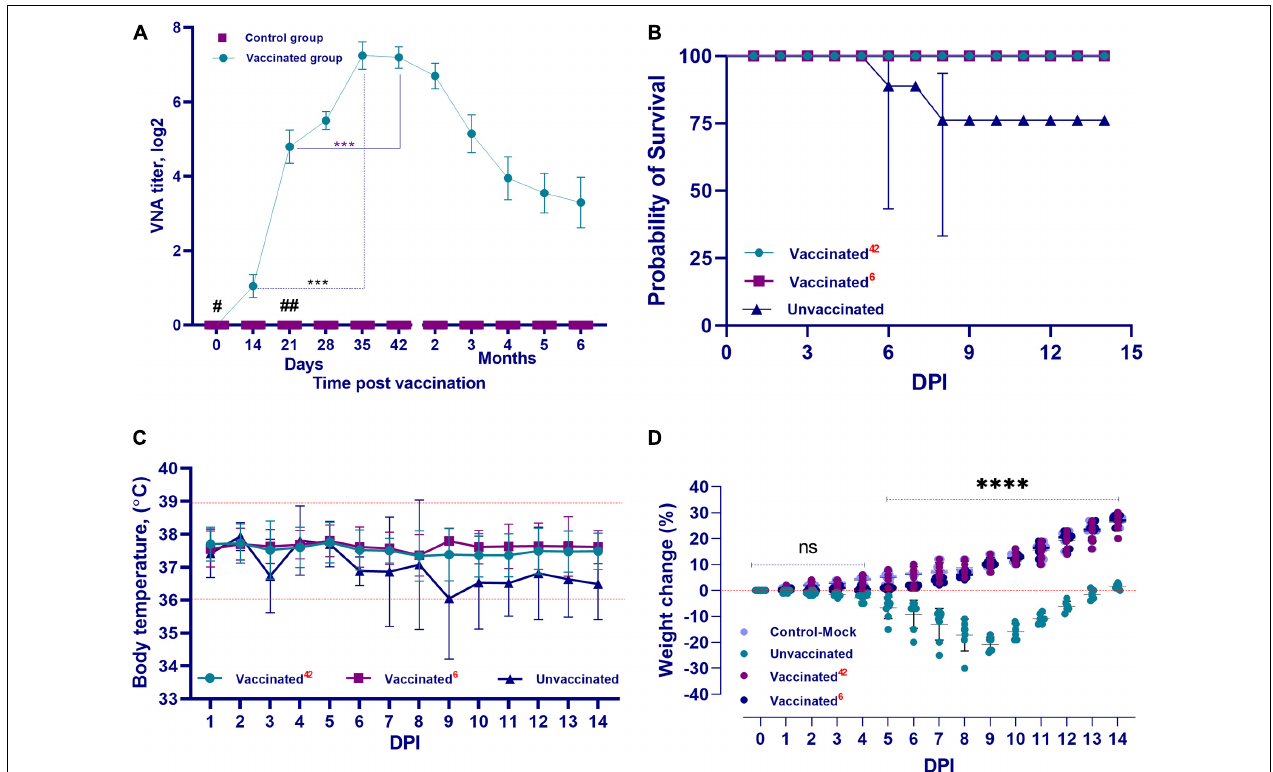
FIGURE 4 | Performance indicators of the inactivated QazCovid-in. (A) Vaccine- virus neutralizing antibodies (VNA) in blood serum samples of Syrian hamsters before (day 0) and after vaccination. The graph shows the average values of VNA titers with standard deviation (mean ± SD). ∗∗∗ p < 0.001. (B) The survival rate of vaccinated and unvaccinated hamsters, after infection with the wild SARS-CoV-2 virus. (C) The temperature reaction of vaccinated and unvaccinated hamsters after challenge with wild homologous SARS-CoV-2 virus. There was no significant difference in average body temperature between the vaccinated and unvaccinated groups ( p ≥ 0.05). (D) Changes in the body weight percentage of vaccinated and unvaccinated hamsters after challenge with the wild homologous SARS-CoV-2 virus; 42 indicates the vaccinated group challenged 42 days after vaccination, 6 indicates the vaccinated group challenged 6 months after vaccination. ns indicates no significance. # The first dose was inoculated on day 0. ## The second dose was administrated on the 21st